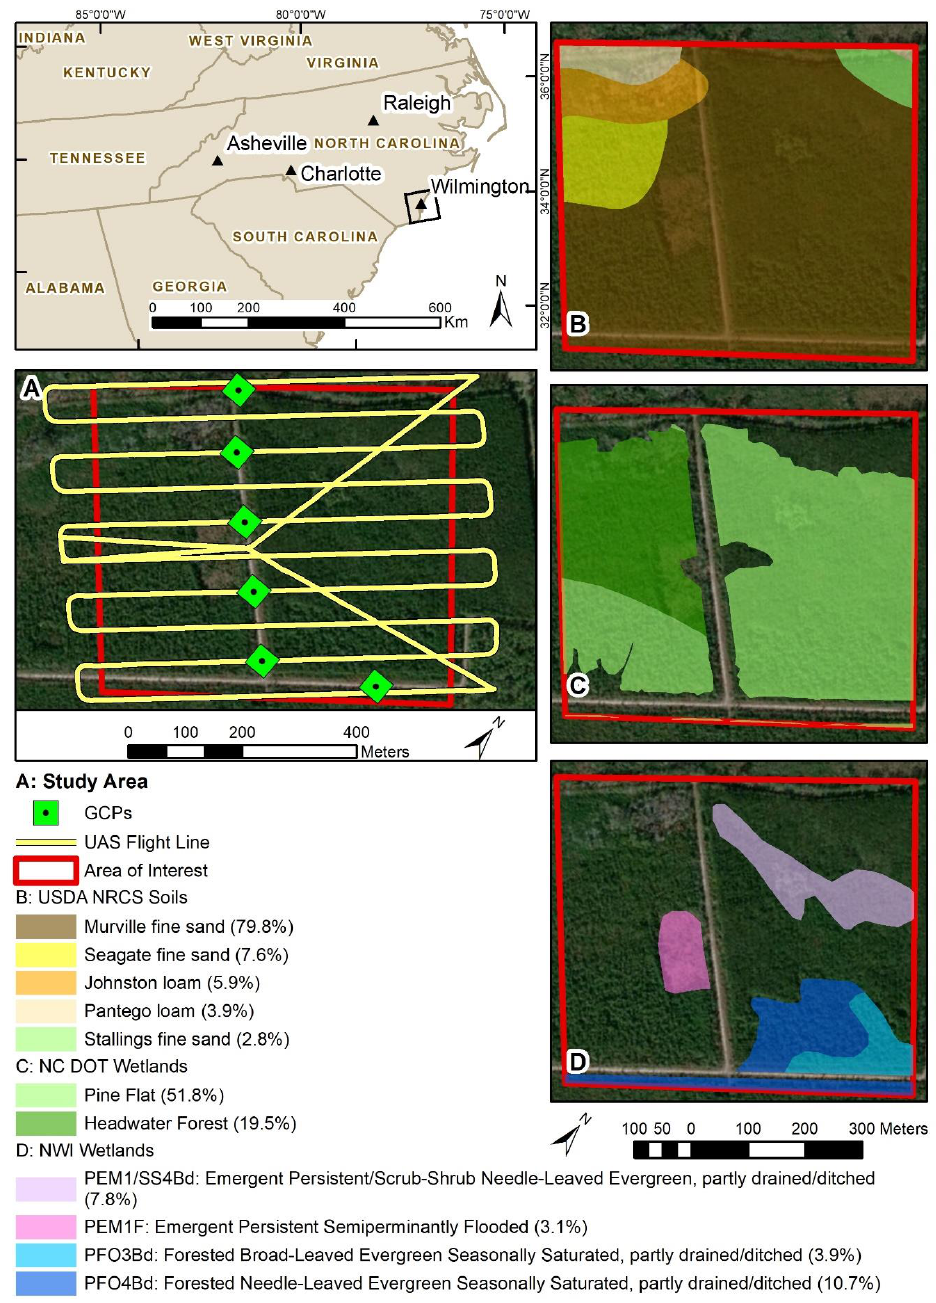
Figure 1. The study area in southeastern North Carolina, USA, dominated by forest cover and showing the UAS flight lines and GCPs ( A ). Additional ancillary data include soils data from the Soil Survey Geographic Database (SSURGO) ( B ), wetlands delineated by the North Carolina Department of Transportation ( C ), and National Wetlands Inventory ( D ).